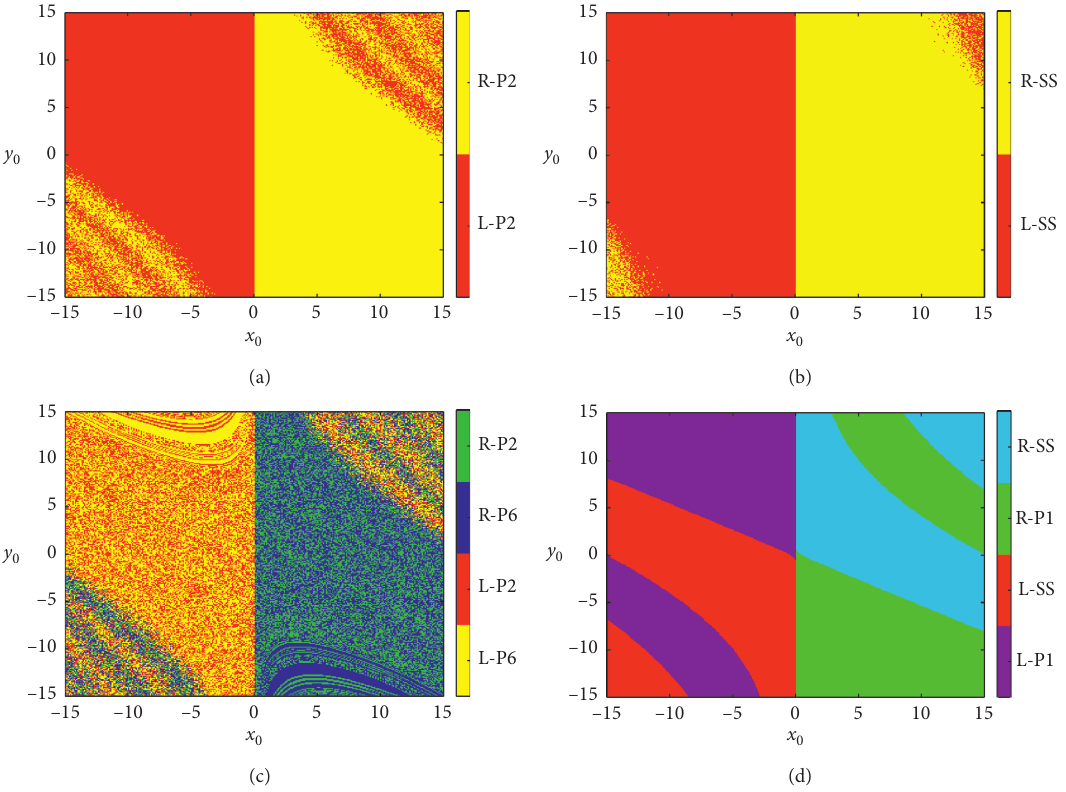
Figure 7: Local attraction basins for four different sets of the model parameters d and f in the x and f � 3. (c) d � 0.3593 and f � 1.88. (d) d � 0.5 and f �